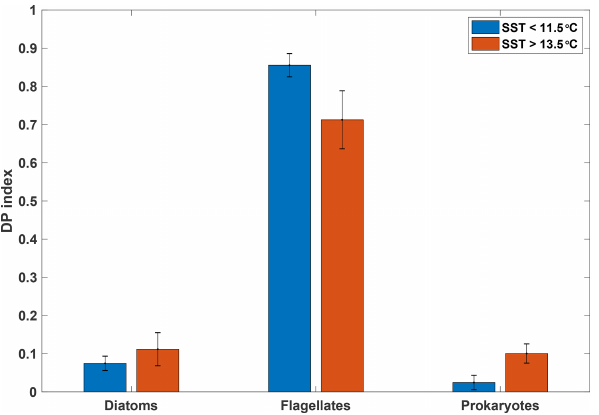
Figure 5. Mean diagnostic pigment (DP) indices calculated based on pigment ratios from HPLC analyses for samples taken from the underway seawater supply, grouped by SST ( n = 6 for SST > 13 . 5 ◦ C; n = 7 for SST < 11 . 5 ◦ C). Error bars indicate 1 standard deviation. See Sect. 2.4.2 for calculation of the DP